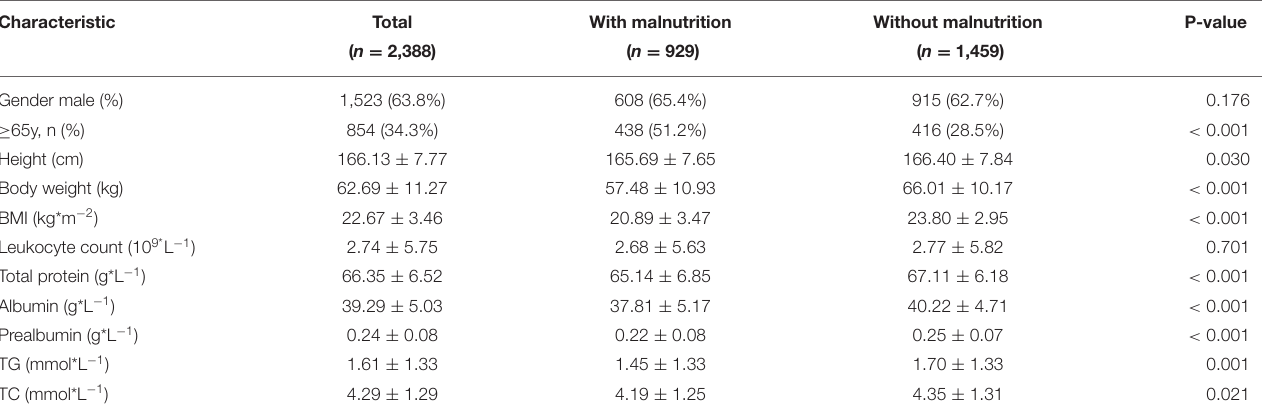
TABLE 1 | Demographic and clinical characteristics of the patients with cancer.